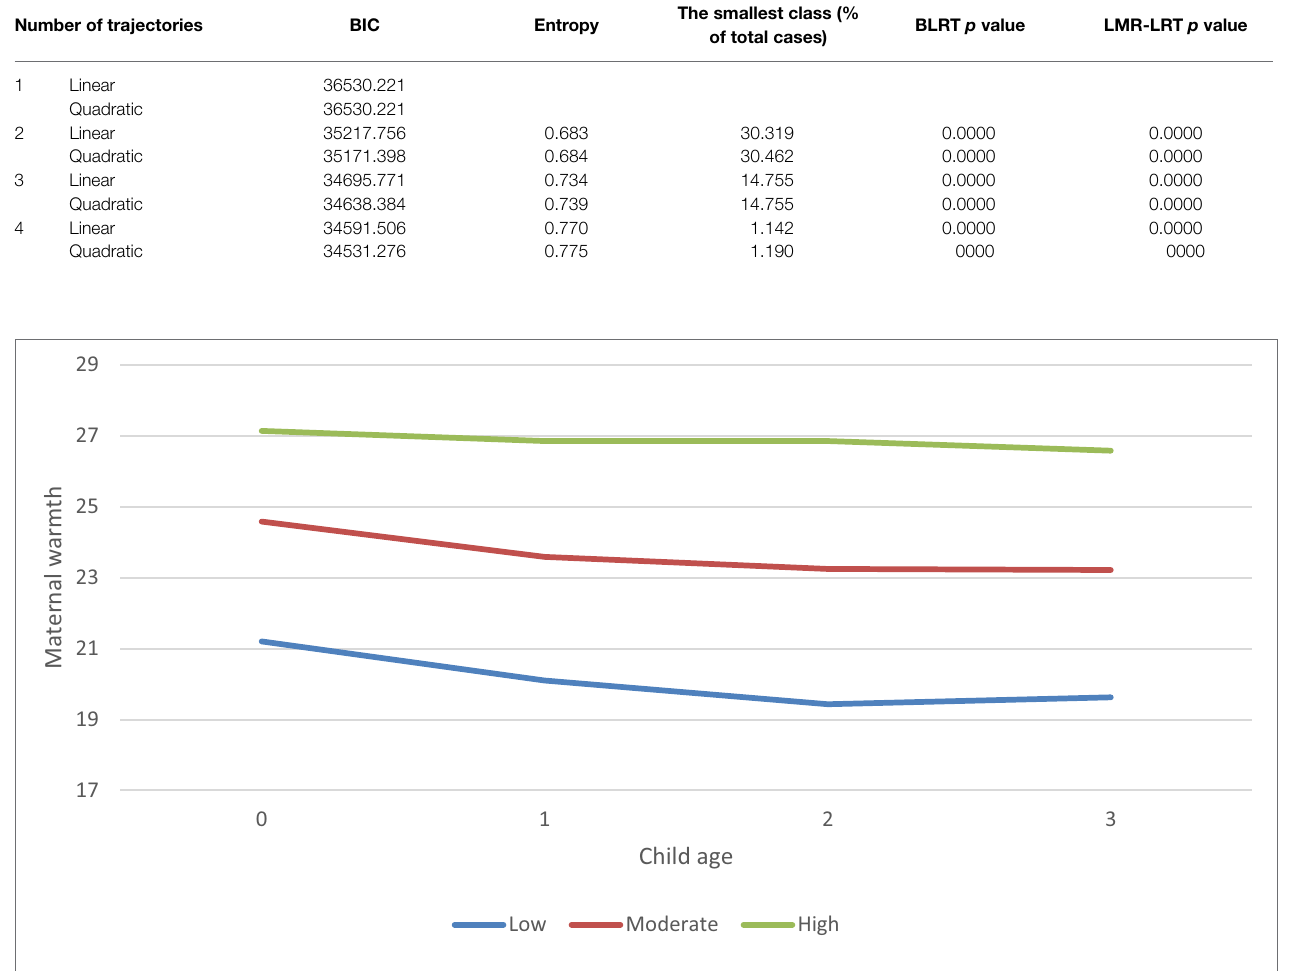
FIGURE 1 | Trajectories of maternal responsive parenting from birth to age 3: sample means.